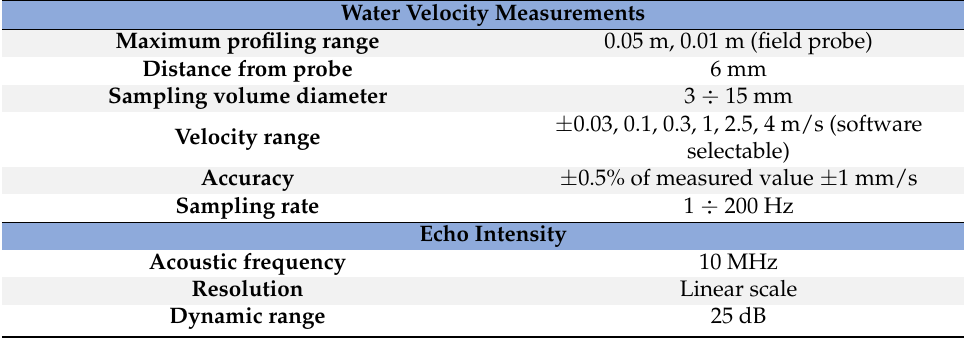
Table 1. Vectrino ADV technical specifications [14] used in the